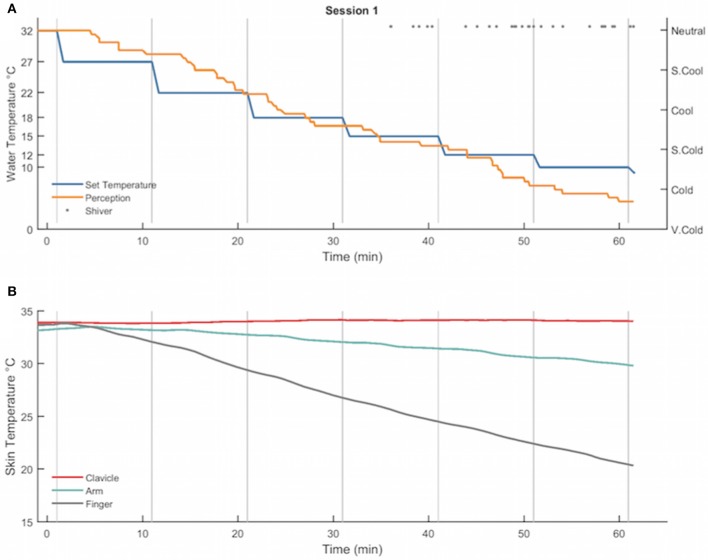
Example of the water temperature set points (°C, blue), subjective perception of cooling ratings (arbitrary units, orange), and self-reported shiver events (gray dots) (A) and clavicle (°C, red), forearm (°C, green line), and finger (°C, gray line) skin temperature gradients (B) recorded from a healthy, young male during a perception-based cooling protocol. During the protocol, the set point of the water temperature (blue line) was adjusted at the end of each 10-min cooling phase (vertical gray lines) according to the subject's thermal perception rating (orange line; see section Individualized, Perception-Based Cooling Protocol for details). The protocol terminated when the subject reported sustained shivering (>1 min in duration; gray dots).